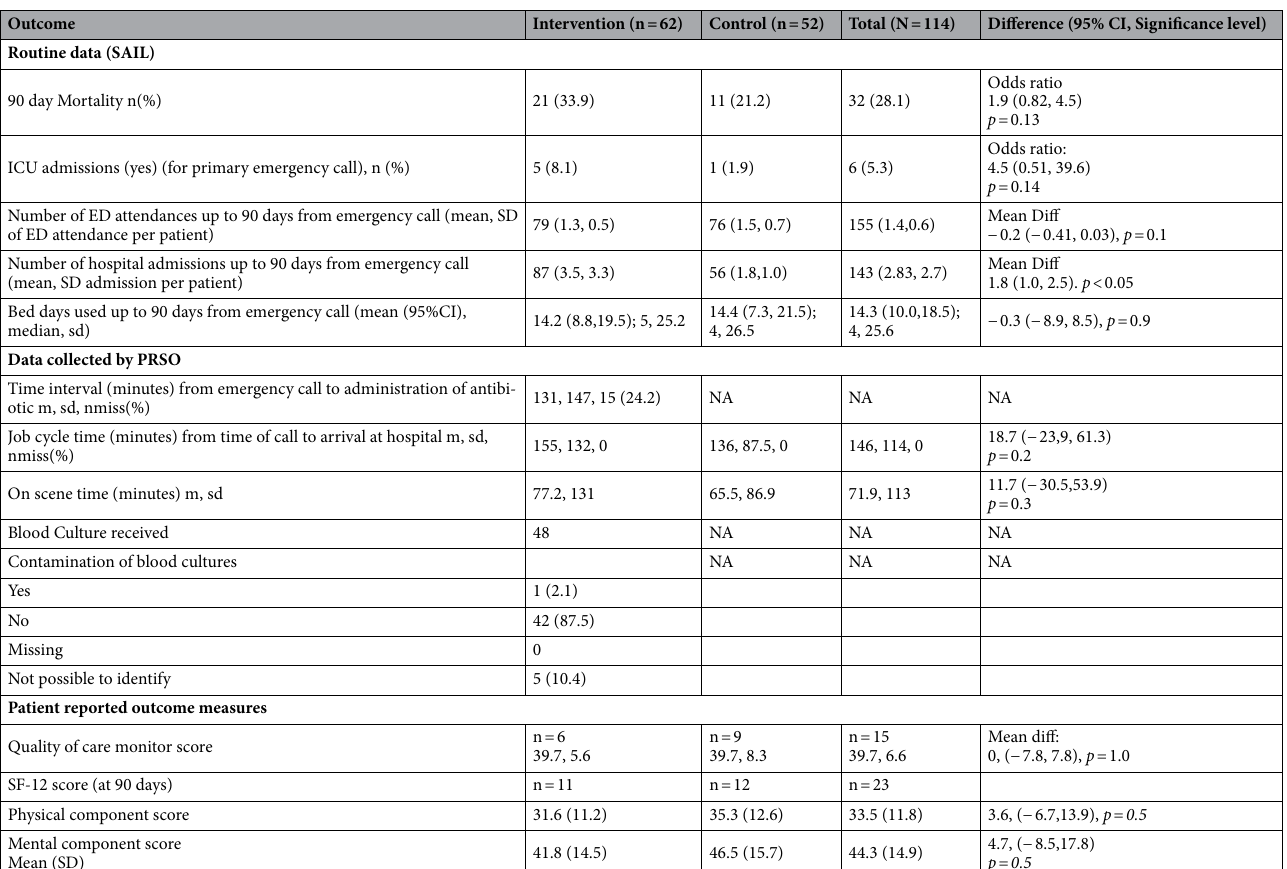
Table 3. Unadjusted analysis of outcomes between groups. M mean, med median, min minimum, max maximum, sd standard deviation, n miss number of